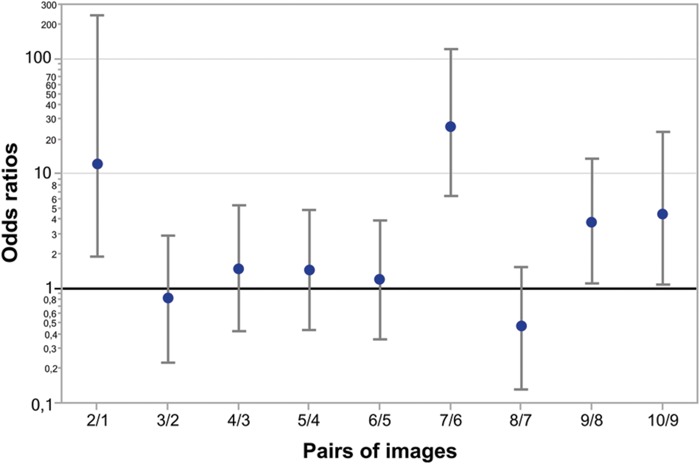
Odds ratios of face recognition between pairs of Face-n-Food images. The most prominent leap in face recognition occurs from the image 6 to 7 with an odds ratio of 26 (95% CI 6.5 to 125; p < 0.0001). There are non-significant odds ratios between pairs 3/2, 4/3, 5/4, 6/5, and 8/7 that indicates no increase in face recognition. The odds ratios between pairs 2/1, 9/8, and 10/9 are significant showing a hop in face resemblance. Vertical bars represent 95% CI.